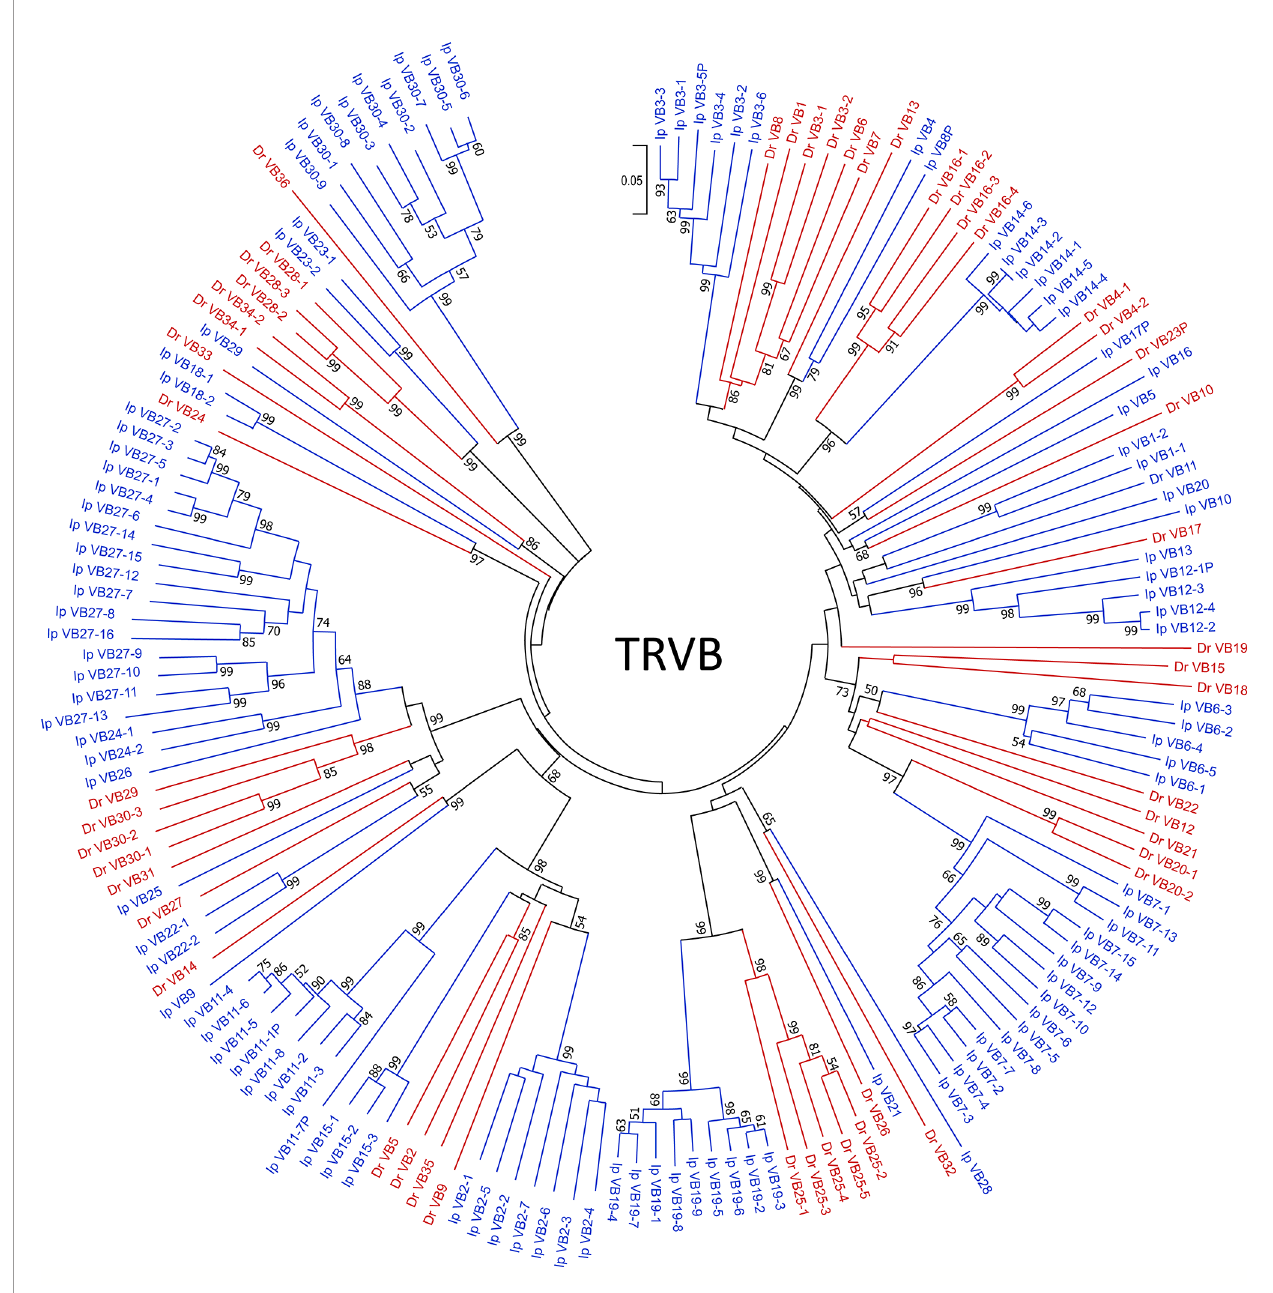
FIGURE 2 | TRBV phylogenetic analysis. TRBV phylogenetic tree topology demonstrates that 10 cat fi sh and zebra fi sh TRBV subgroups are closely related. The evolutionary history was inferred using the Neighbor-Joining method (47). The percentage of replicate trees in which the associated taxa clustered together in the bootstrap test (10,000 replicates) are shown next to the branches (48). The tree is drawn to scale, with branch lengths in the same units as those of the evolutionary distances used to infer the phylogenetic tree. The evolutionary distances were computed using the p-distance method (49) and are in the units of the number of base differences per site. The analysis involved 163 nucleotide sequences. Prior to analysis, sequences were trimmed to include 22 codons before the codon for the fi rst cysteine (CYS23) to 6 nucleotides past the last cysteine (CYS104). All ambiguous positions were removed for each sequence pair (pairwise deletion option). There were a total of 382 positions in the fi nal dataset, and evolutionary analyses were conducted in MEGA X (40). Zebra fi sh sequences are colored in red, and cat fi sh are indicated in blue. Bootstrap values below a cutoff of 50 have been omitted for